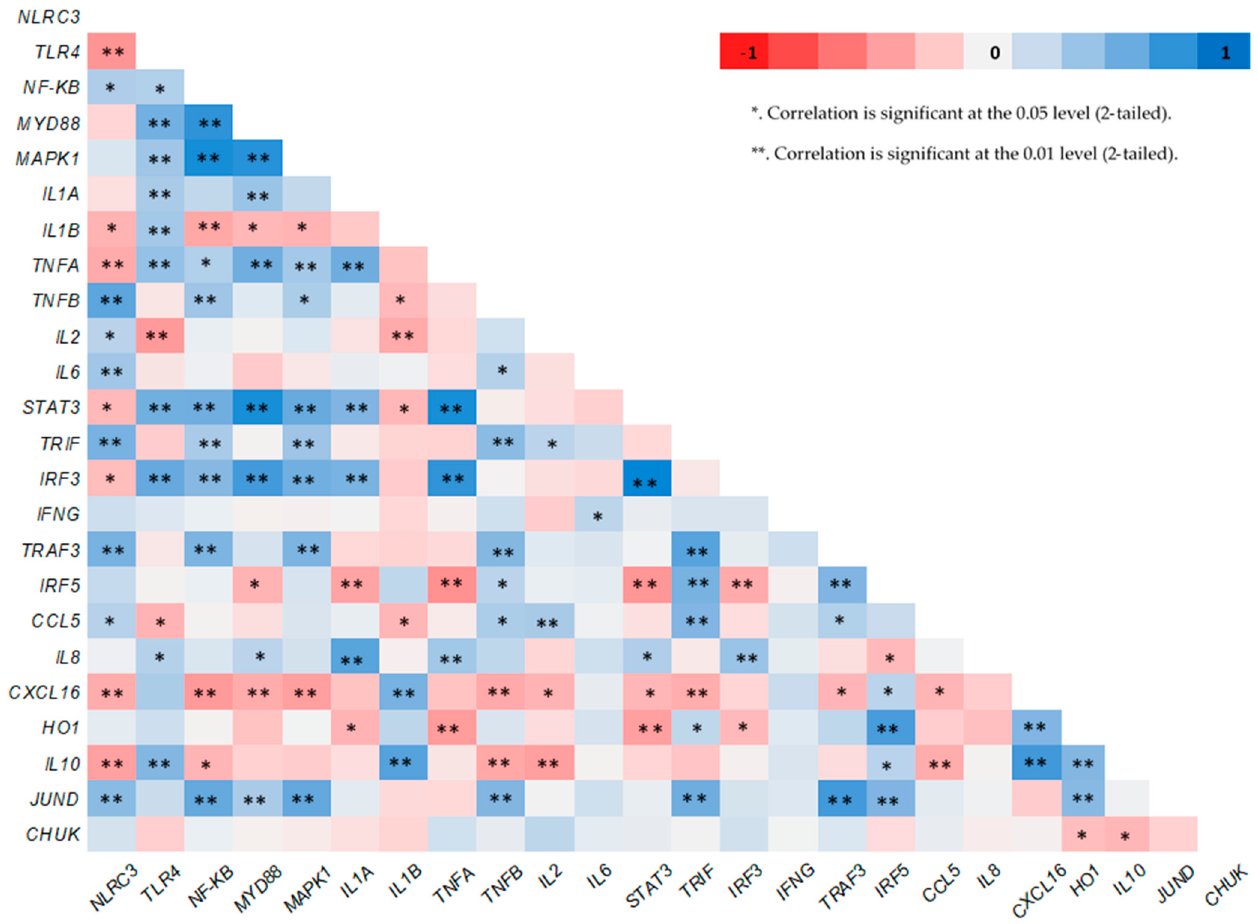
Figure 2. Pearson’s heat map correlations between the expression level of several genes in neutrophils of goats.